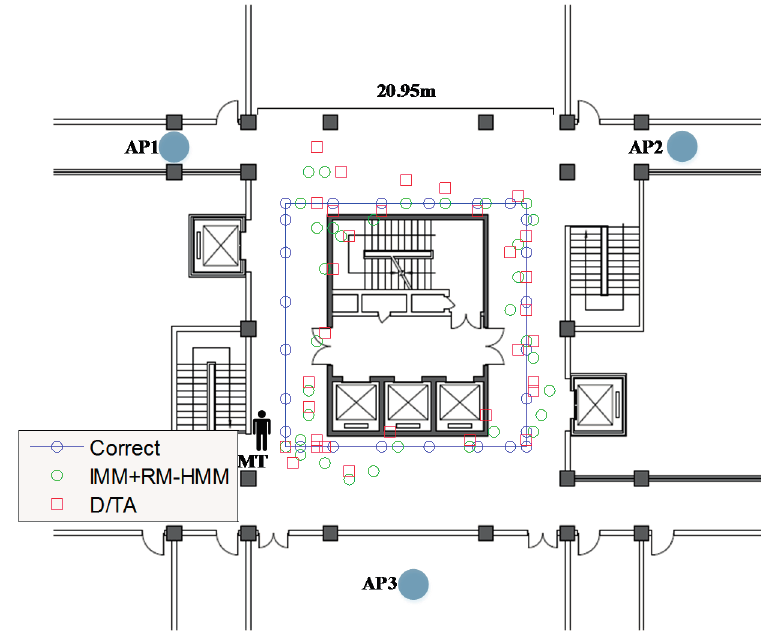
Figure 23. The trajectory of the MT in simulation.